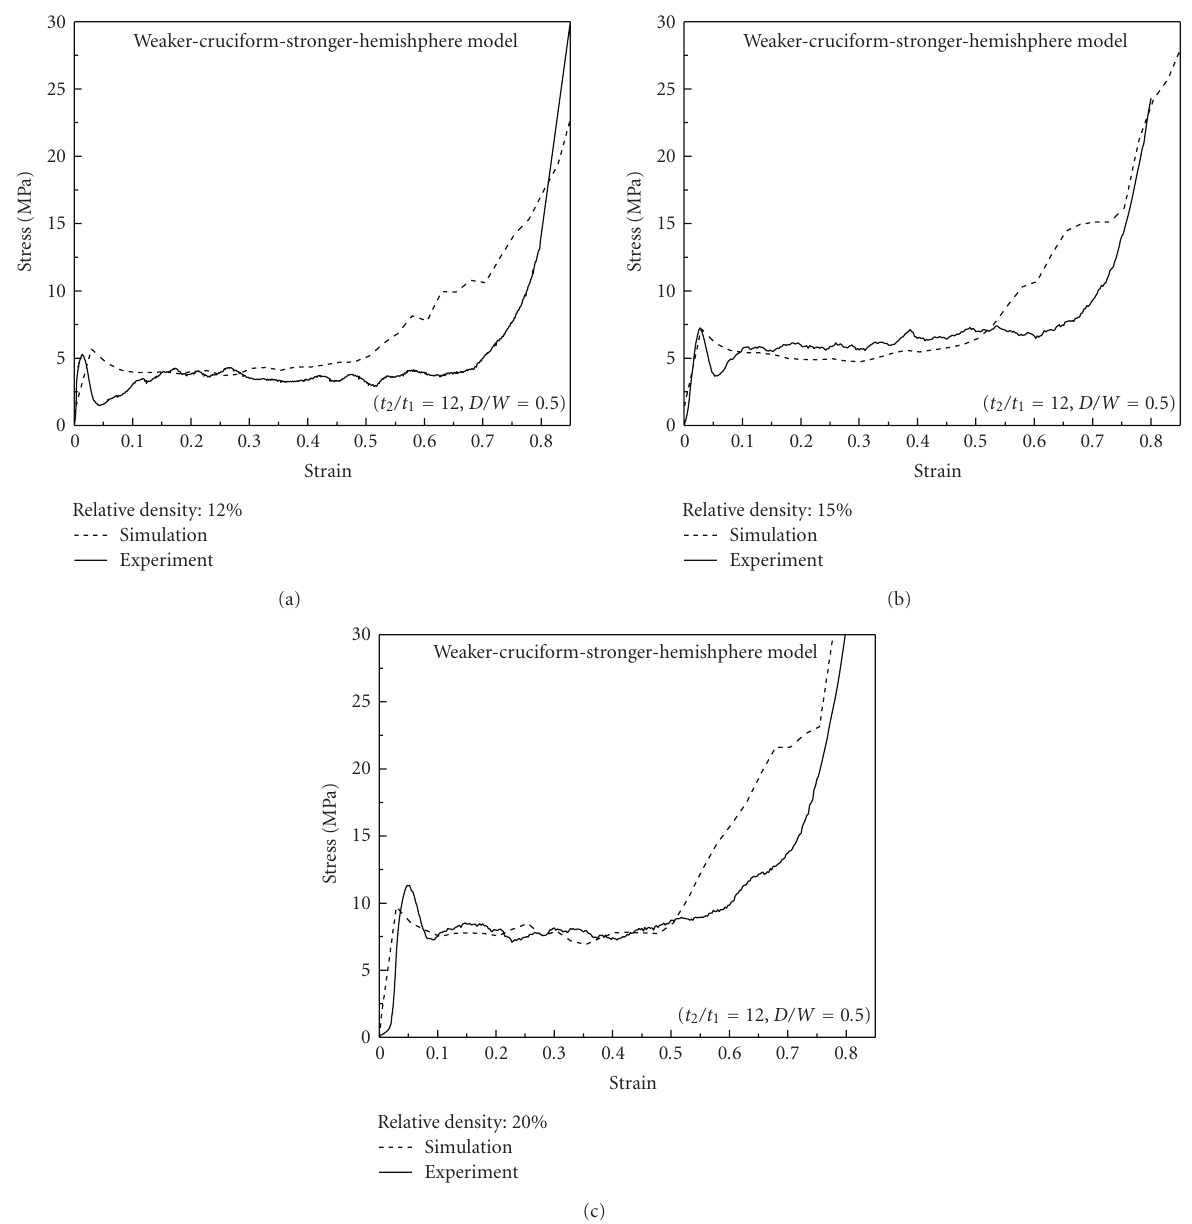
Figure 9: Experimental and simulated stress-strain curves using the improved weaker-cruciform-stronger-hemisphere model (a) relative density = 12%, (b) relative density = 15%, (c) relative density = 20%.